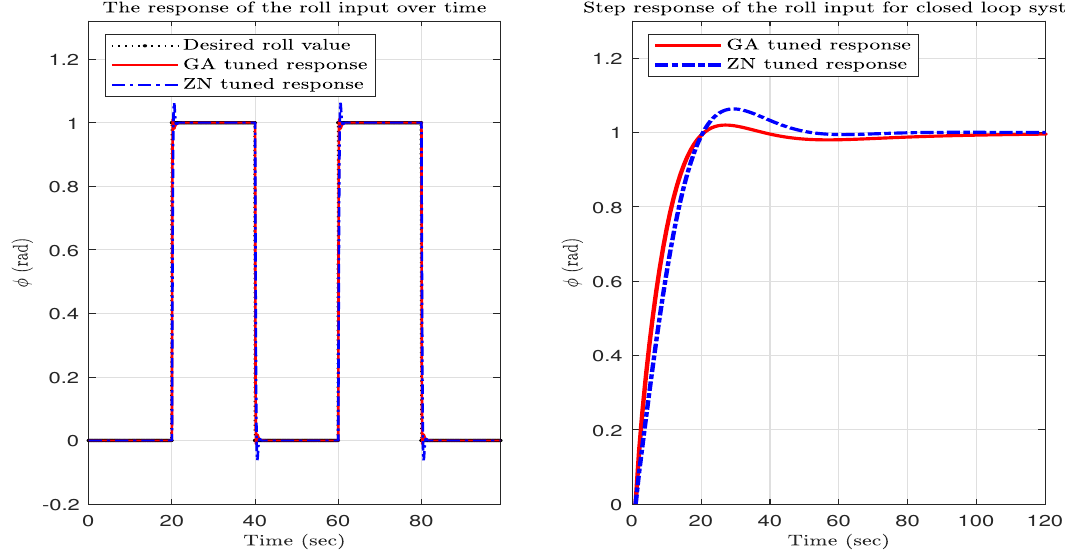
Figure 7. Simulated output responses of the roll input of a quadcopter using GA and ZN